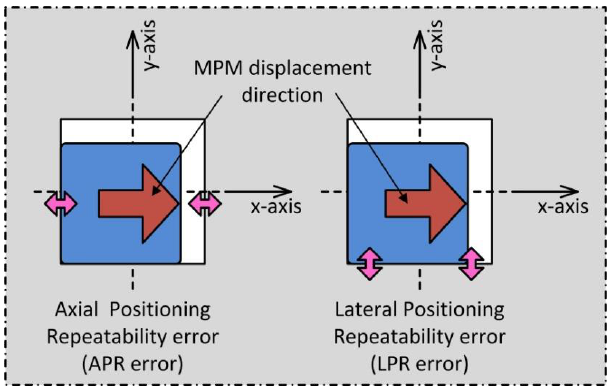
Figure 8. Representation of the axial positioning repeatability error (APR error) and of the lateral positioning repeatability error (LPR